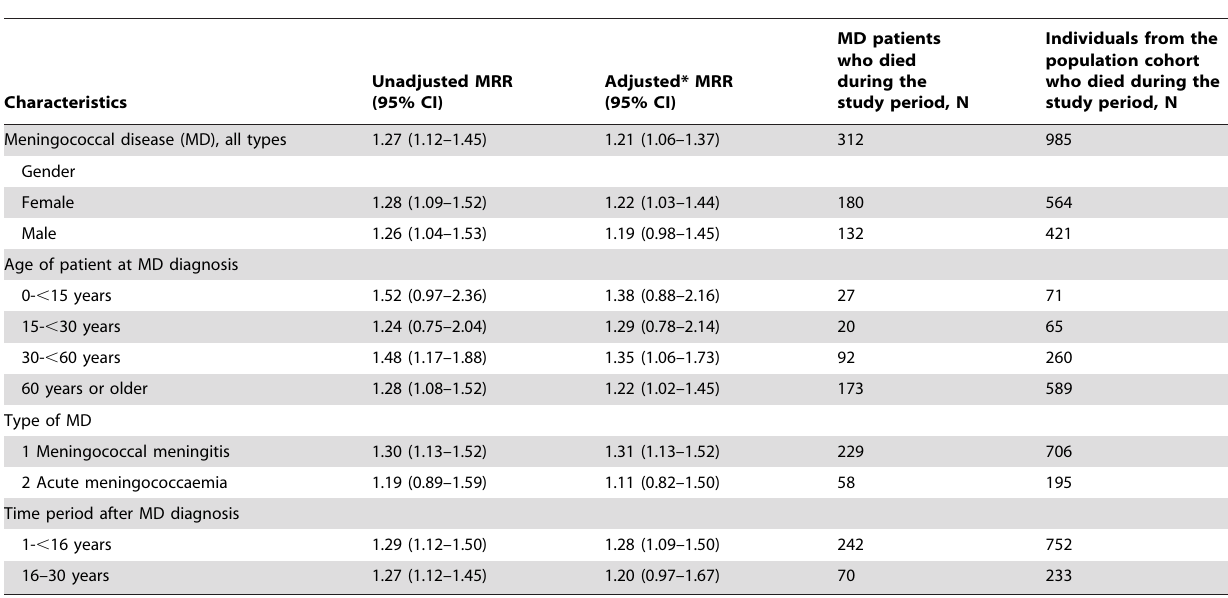
Table 2. Mortality rate ratios (MRR) for MD patients compared to individuals from the population cohort.